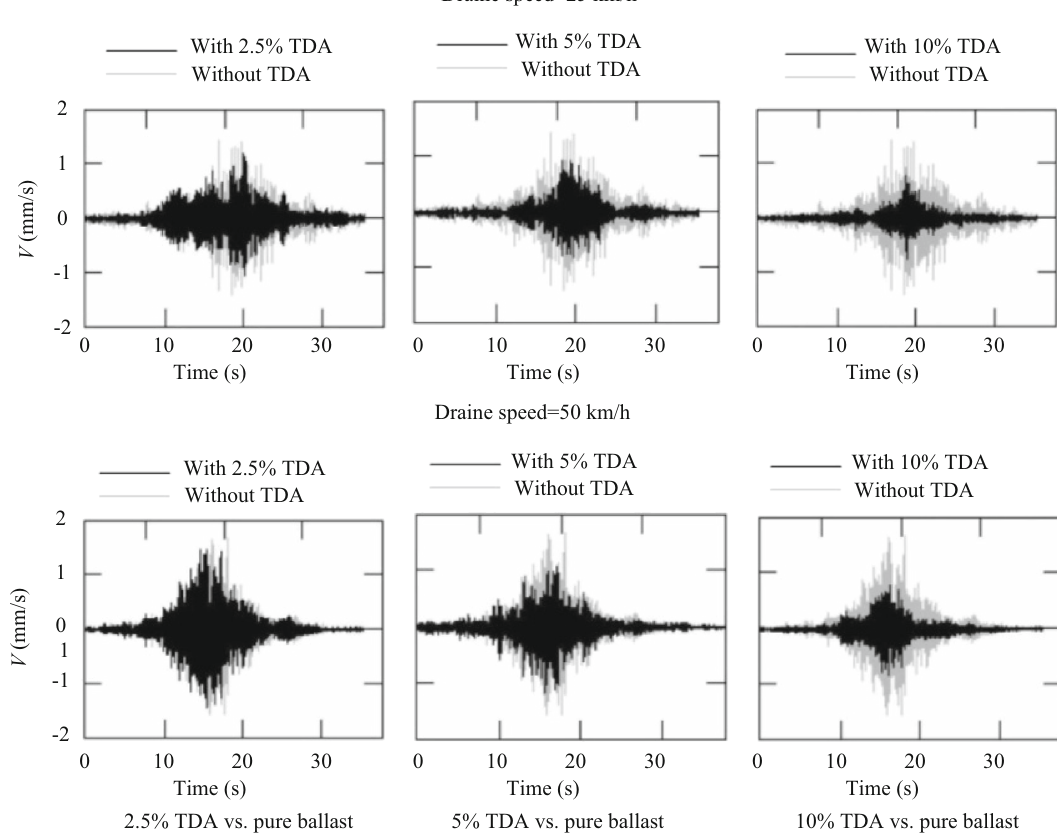
10% TDA vs. pure ballast